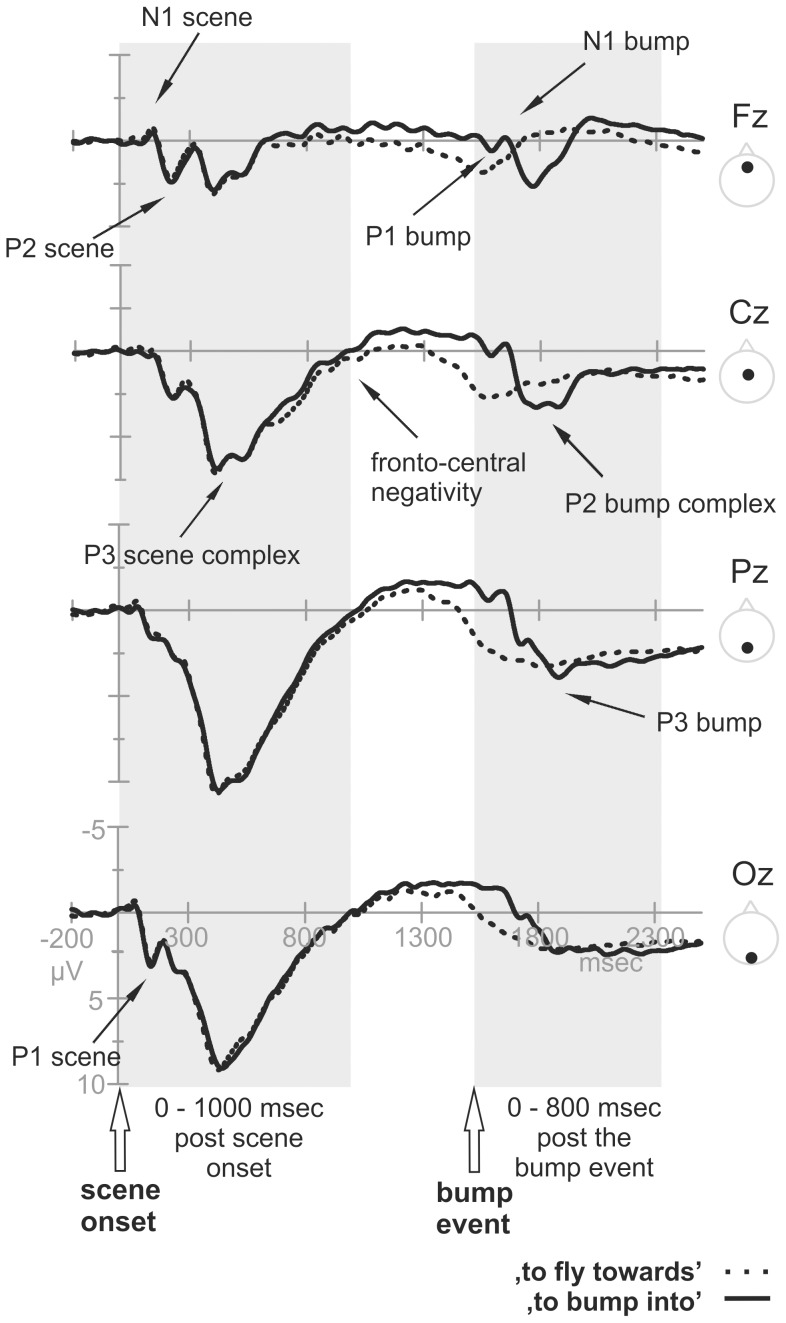
Overview of ERPs.Grand average ERPs, separately for the two action formats (solid lines = ‘to bump into’; dashed lines = ‘to fly towards’), across the midline of the scalp (F = Frontal, C = Central, P = Parietal, O = Occipital) for the entire epoch interval of −200 to 2500 ms after scene onset, reflecting the speech planning from stimulus onset onwards. The two time windows of interest are highlighted: the post scene onset time window (where scenes of both action formats, and their corresponding ERPs, are still identical) and the post bump event time window (where the analysis was limited to the ‘to bump into’ trials, as the ‘to fly towards’ trials did not show an ERP morphology during this time window). Target components are indicated by arrows. Negative voltage is plotted upward in this and all subsequent figures. Note that for plotting purposes, ERP waveforms underwent a low pass filter (5 Hz, 6 dB cut-off).